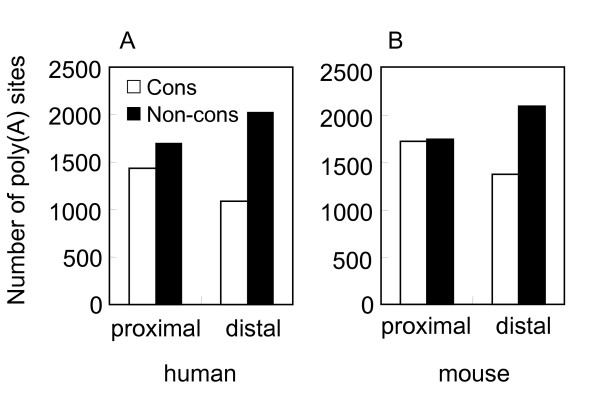
Distribution of polyadenylation sites in proximal or distal parts of 3'UTRs. Numbers of conserved sites ("Cons", white) and non-conserved sites ("Non-cons", black) located in proximal or distal parts of 3'UTR regions are shown for human (A) and mouse (B).